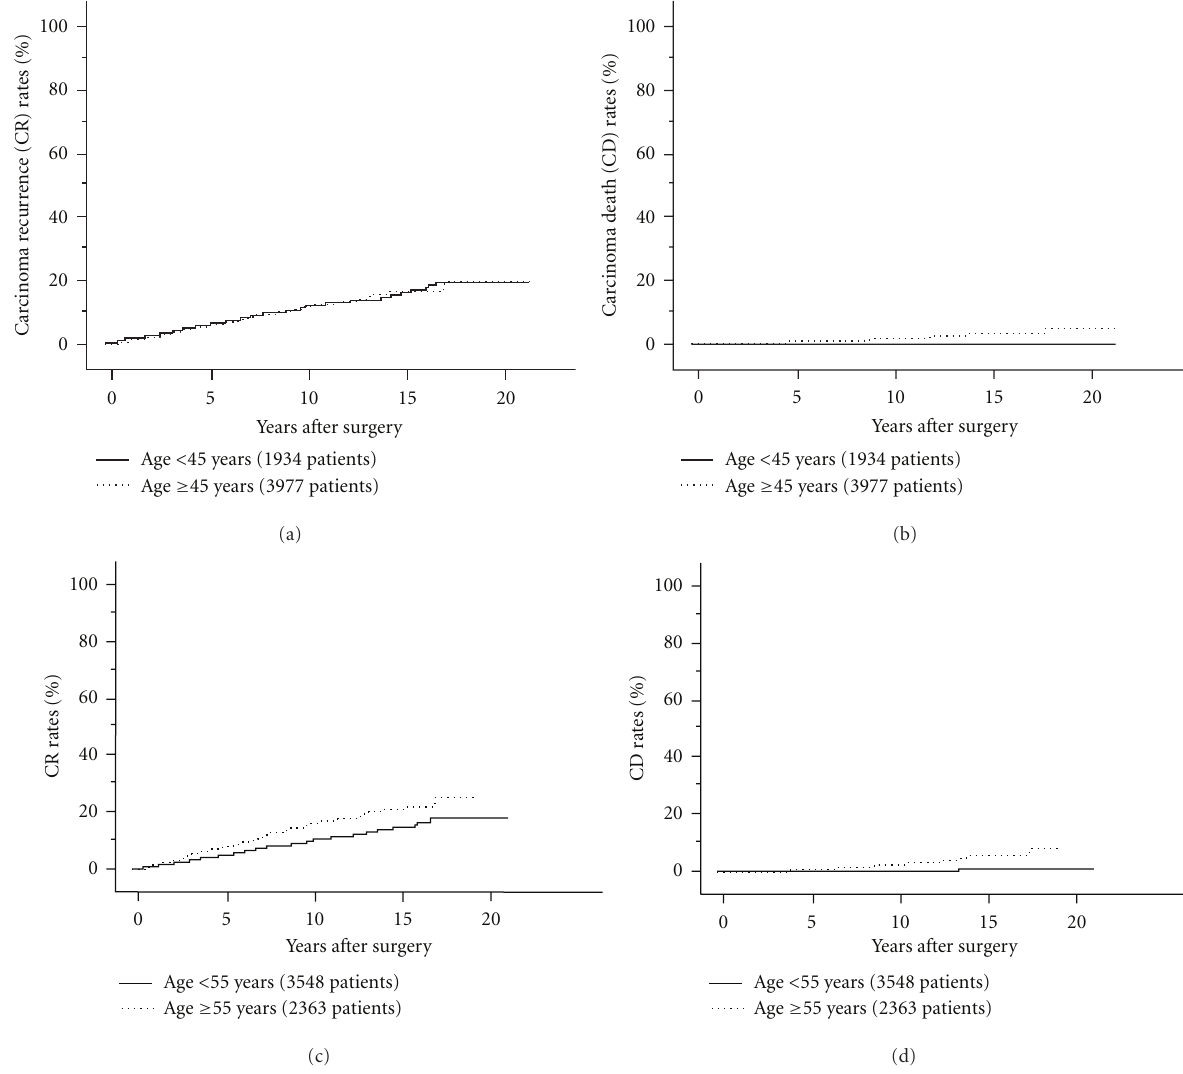
Figure 1: (a) Carcinoma recurrence (CR) rate of PTC patients aged 45 years or older and those younger than 45 years. (b) Carcinoma death (CD) rates of PTC patients aged 45 years or older and those younger than 45 years. (c) CR rates of PTC patients aged 55 years or older